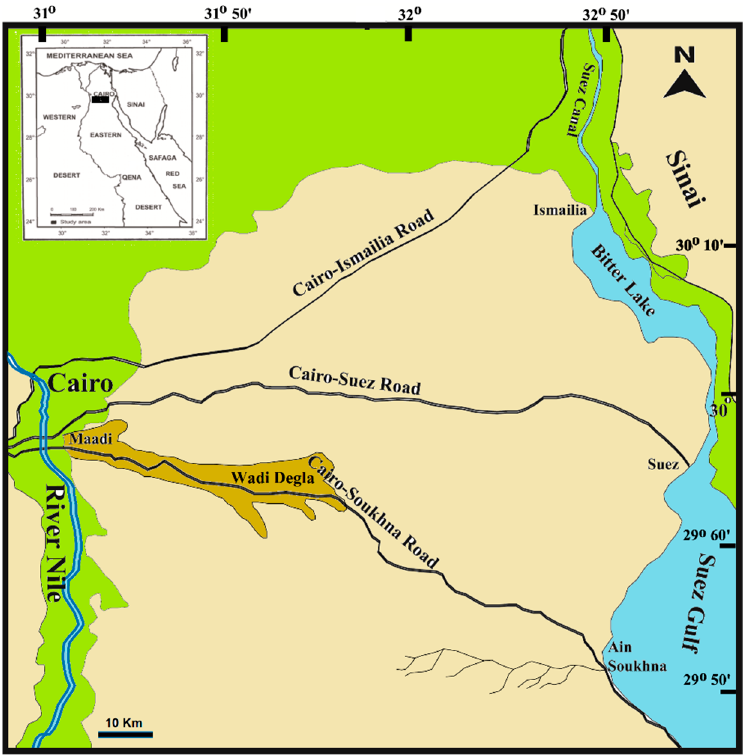
Figure 1. Location map showing the Cairo ‐ Suez road and Wadi Degla protected area (shaded in brown).